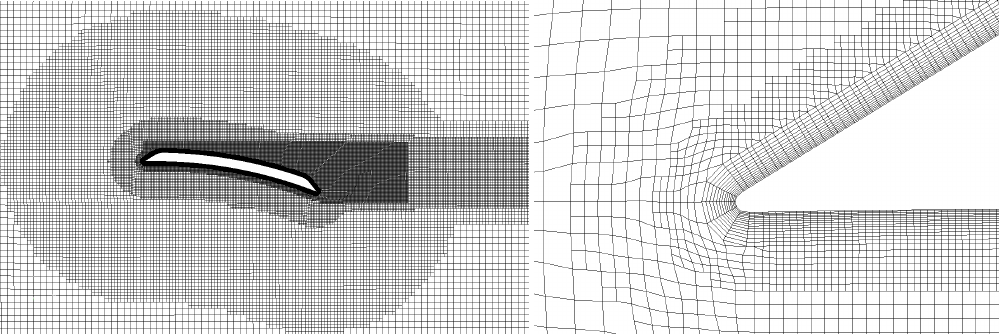
Figure 2. Example of mesh details for AoA = 10 ◦